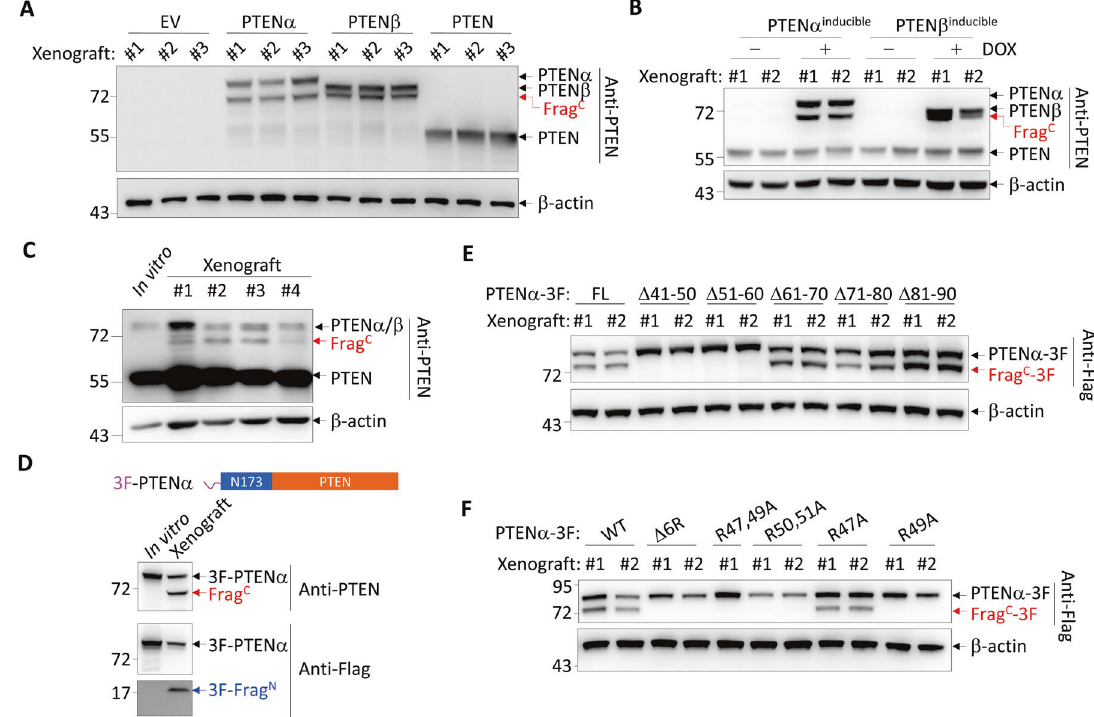
Fig. 1 PTEN α / β are cleaved within their NTEs. A , B Xenografts derived from PTEN -knockout SMMC-7721 cells stably expressing EV, PTEN α , PTEN β , or PTEN ( A ) and from SMMC-7721 cells with inducible expression of PTEN α or PTEN β under the control of a doxycycline-inducible expression system ( B ) were subjected to Western blot for proteins as indicated. ( C ) Western blot analysis in the lysates of in vitro-cultured SMMC-7721 cell line and its 4 xenografts. D Schematics of N-terminal 3×Flag-tagged PTEN α (3F-PTEN α ) (top). Western blot analysis for indicated proteins in the lysates of in vitro-cultured PTEN -knockout SMMC-7721 cell line stably expressing 3F-PTEN α and the xenograft derived from it (bottom). E , F Western blot analysis for indicated proteins in xenografts derived from PTEN -knockout SMMC-7721 cells stably expressing indicated PTEN α derivatives. EV, empty vector; 3 F,